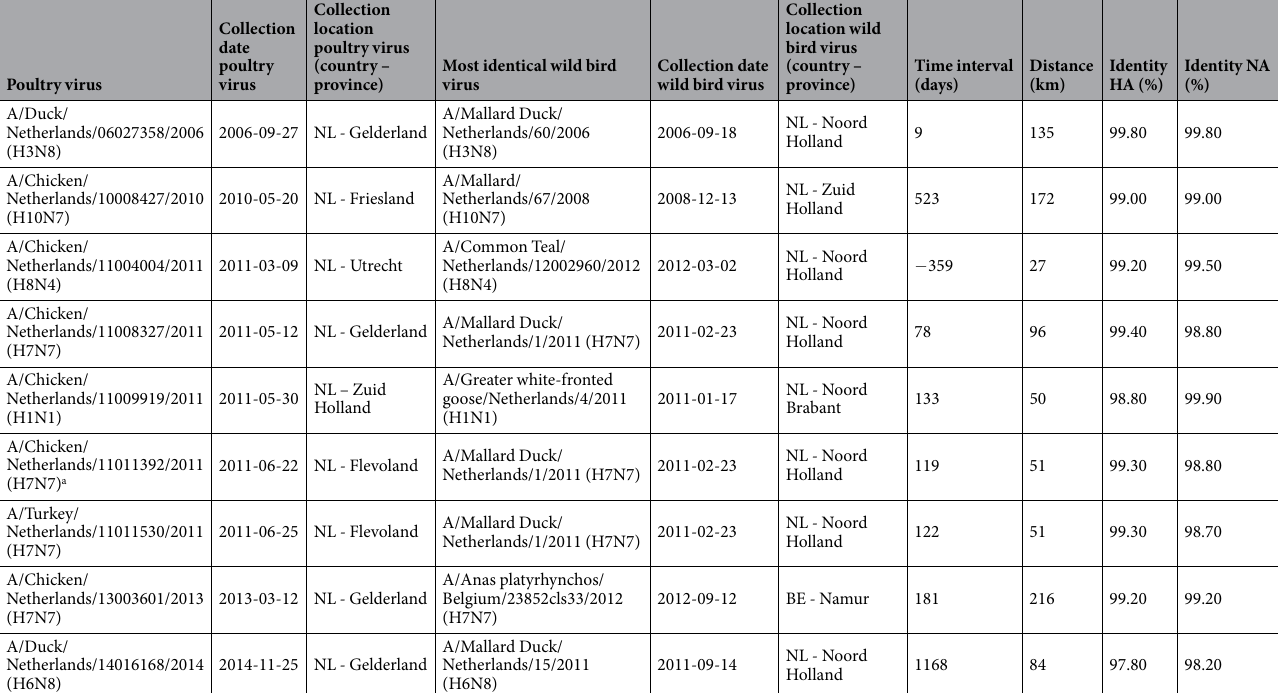
Table 1. Poultry viruses and their most identical wild bird virus. Low pathogenic avian influenza (LPAI) poultry viruses, detected as part of the national avian influenza (AI) surveillance program in the Netherlands, January 2006-September 2016, for which the same most identical wild bird virus was identified for the hemagglutinin (HA) and neuraminidase (NA) gene segment sequences by BLAST. The time interval between collection dates, the distance between the collection locations and nucleotide sequence identities between the HA and NA gene segments of the poultry and wild bird viruses are shown. We gratefully acknowledge the authors, originating and submitting laboratories of the sequences from GISAID’s EpiFlu Database [28] on which this research is based. All submitters of data may be contacted directly via the GISAID website (http:// www.gisaid.org). BE = Belgium, NL = The Netherlands. a A/Chicken/Netherlands/11011392/2011 (H7N7); A/ Chicken/Netherlands/11011326/2011